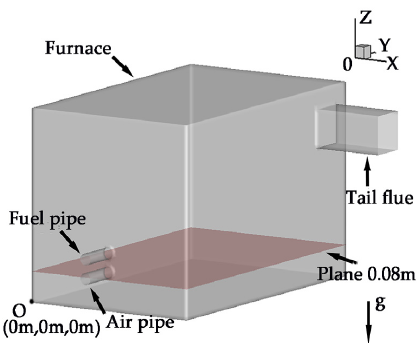
Figure 1. Schematic diagram of the simulation model.